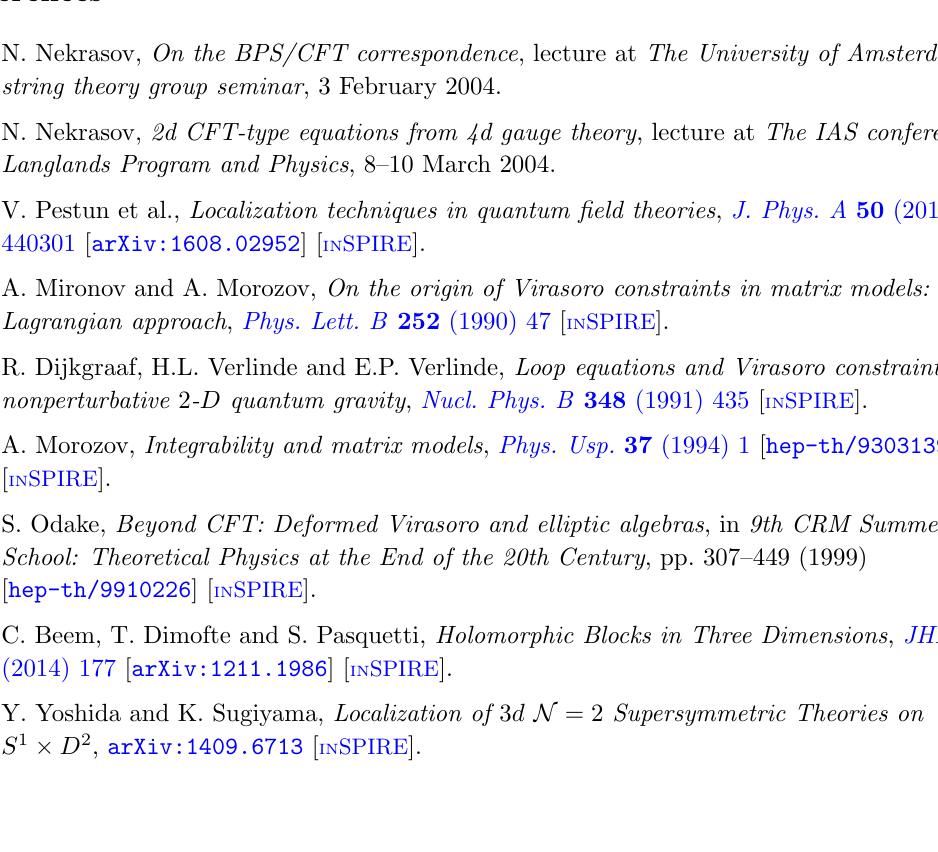
Figure 2 . Closed integration contour for evaluating the partition function Z the schematic locations of simple